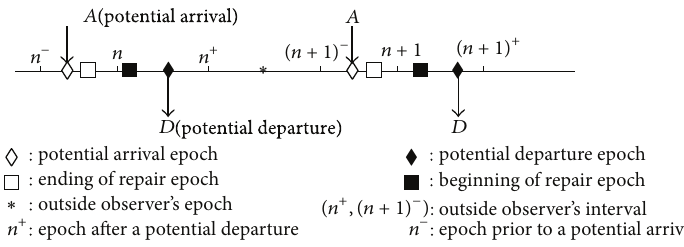
Figure 1: Various time epochs in a late arrival system with delayed